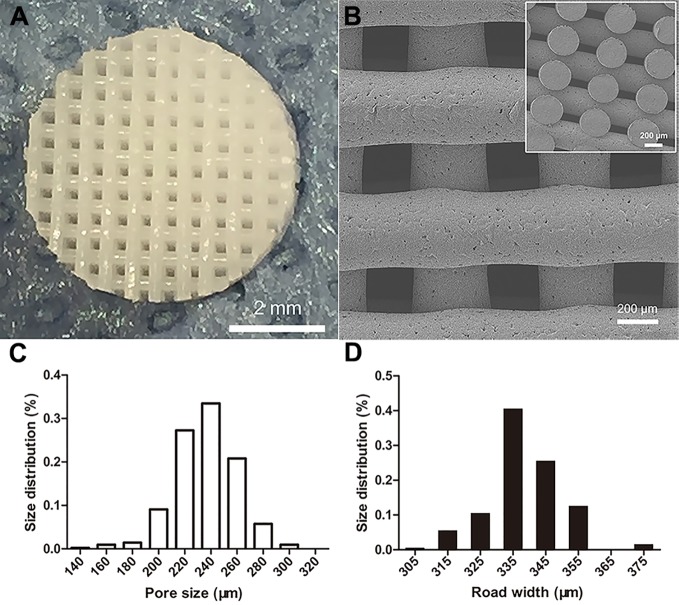
Morphological characteristics of poly(ε-caprolactone) (PCL) scaffolds. The PCL specimen with 6.0 mm in diameter and 2.5 mm height, scale bar represented 2 mm (A). The SEM image of top surface and cross-section of scaffold, scale bar represented 200 µm (B). The distribution of PCL scaffolds' micropore size (C) and road width (D).